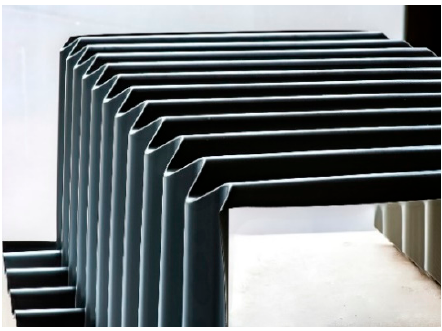
Figure 4. Bent corrugated sheet.